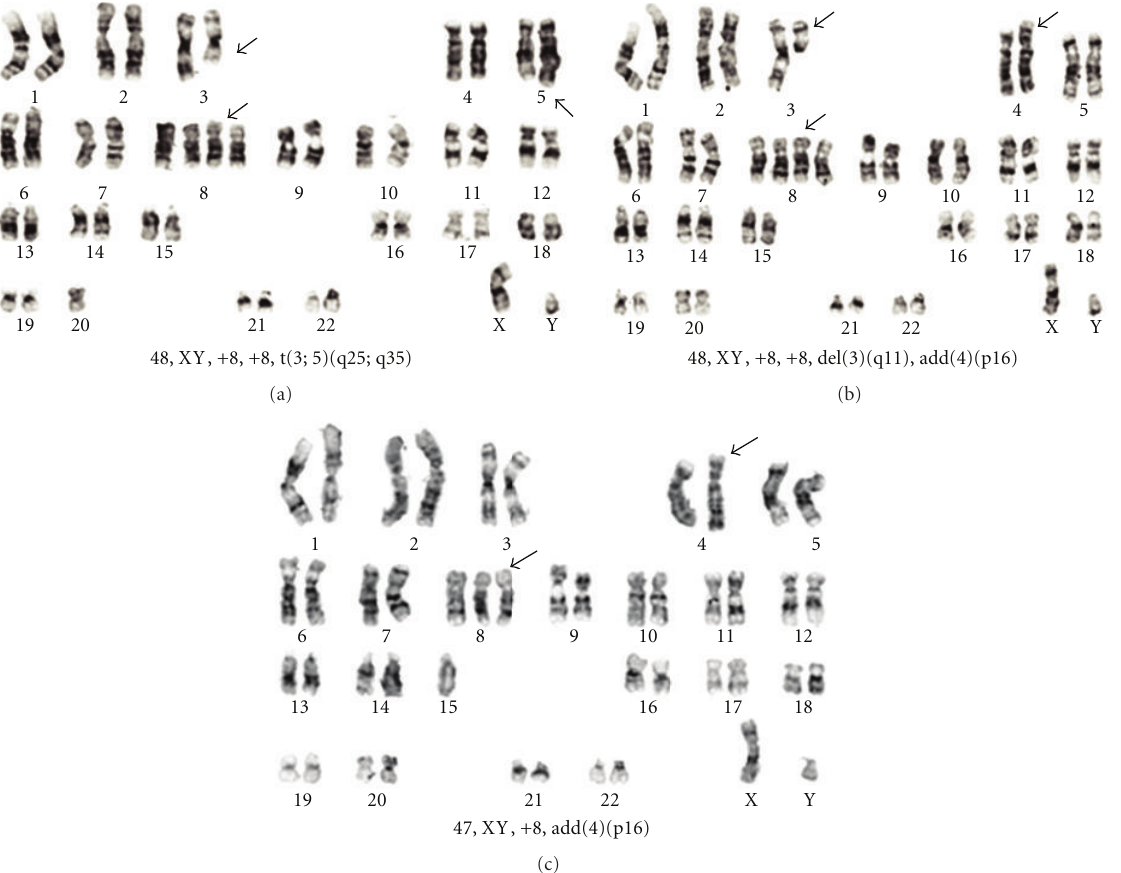
Figure 2: Histiocytic sarcoma karyotype. Alterations not pointed by arrows were not